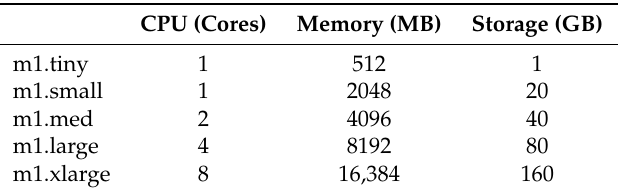
Table 4. Resource types for experiment